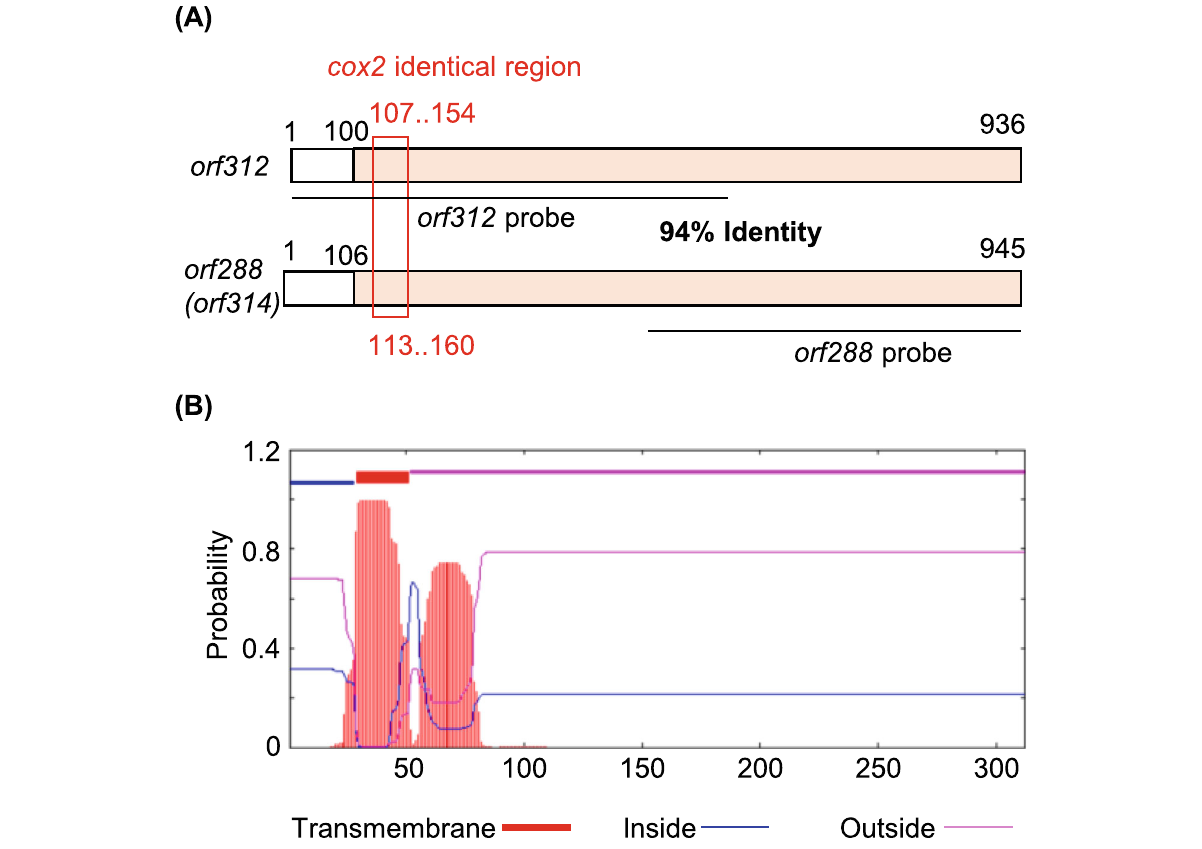
Fig. 3 Schematic structure of the CMS-associated gene orf312 . a Similarities of the orf312 gene of TAA and the orf288 gene of Nipponbare. The pink region (100th to 936th nucleotides) shows 94% identity. b The location and probability associated with the predicted transmembrane domain of